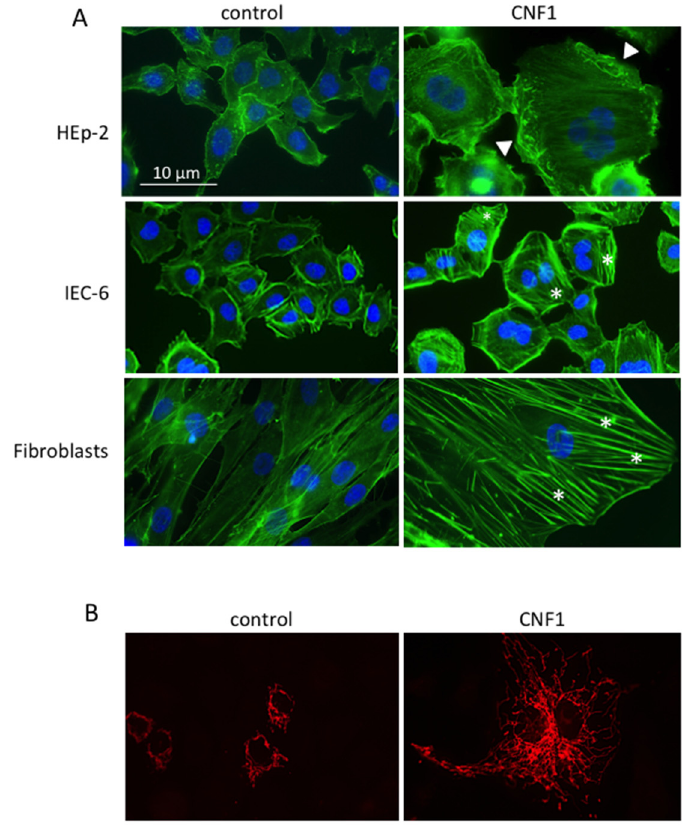
Figure 2. Example of morphological effects of CNF1 on actin and mitochondria. ( A ) F-actin and nuclei staining of different cell lines untreated or treated with CNF1. Asterisks: stress fibers; arrow-heads: ruffles. ( B ) Mitochondrial staining of control and CNF1-treated IEC-6 cells. Note the enrichment of the mitochondrial network in treated cells.